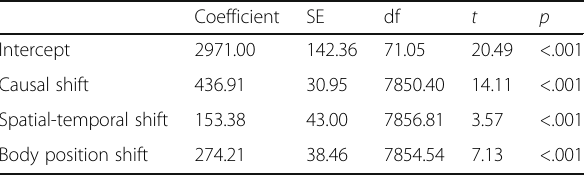
Table 7 Results from linear mixed effects model using situational analysis variables (experiment 2) Coefficient SE df